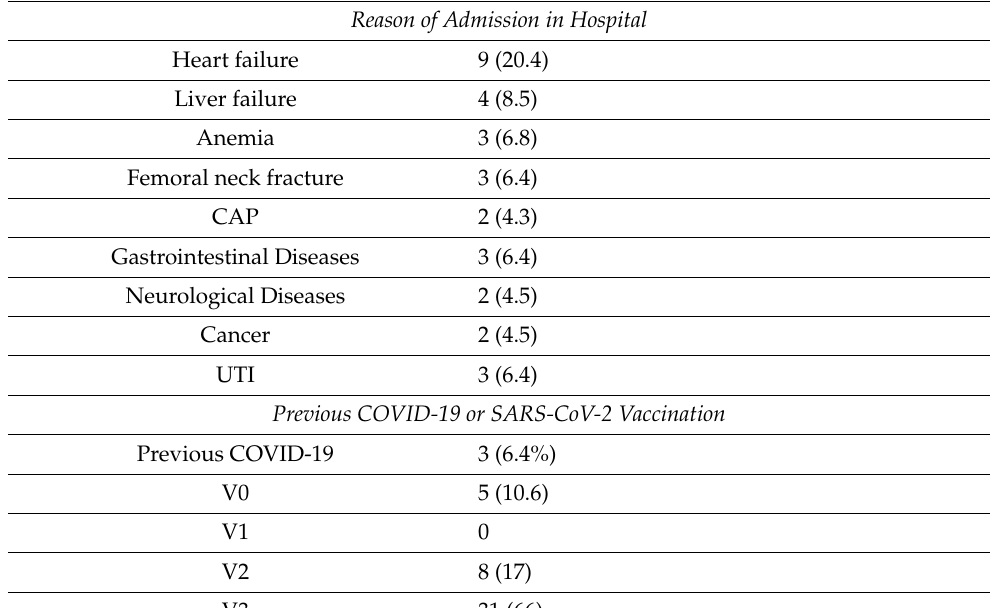
Table 1. Cont. Main Characteristics of Hospitalized Patients Treated with Molnupiravir n = 44